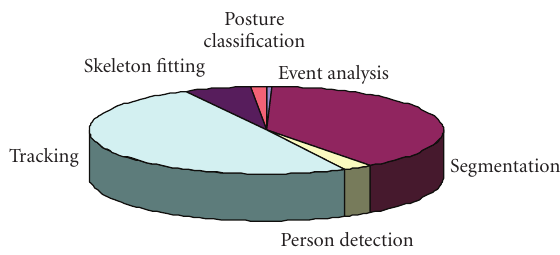
Figure 8: System performance: average time-consuming percentage of each